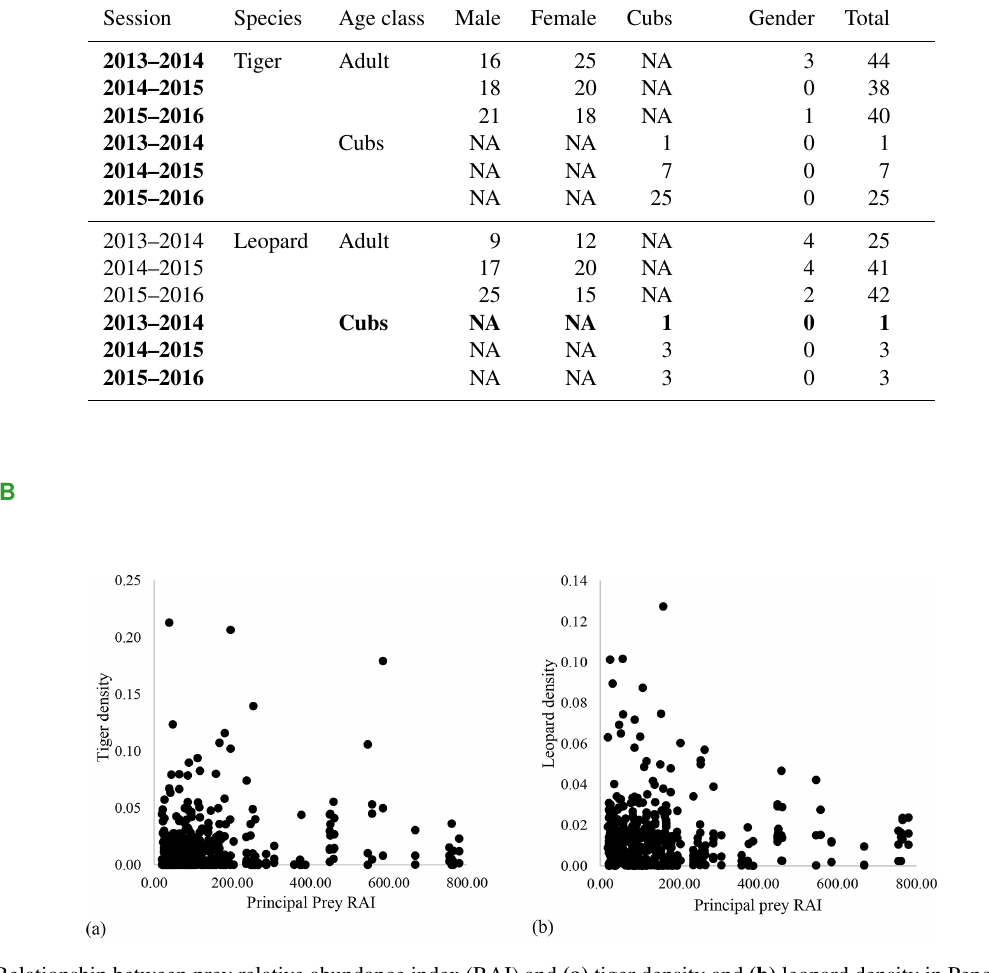
Figure B1. Relationship between prey relative abundance index (RAI) and (a) tiger density and (b) leopard density in Pench Tiger Reserve, Madhya Pradesh.